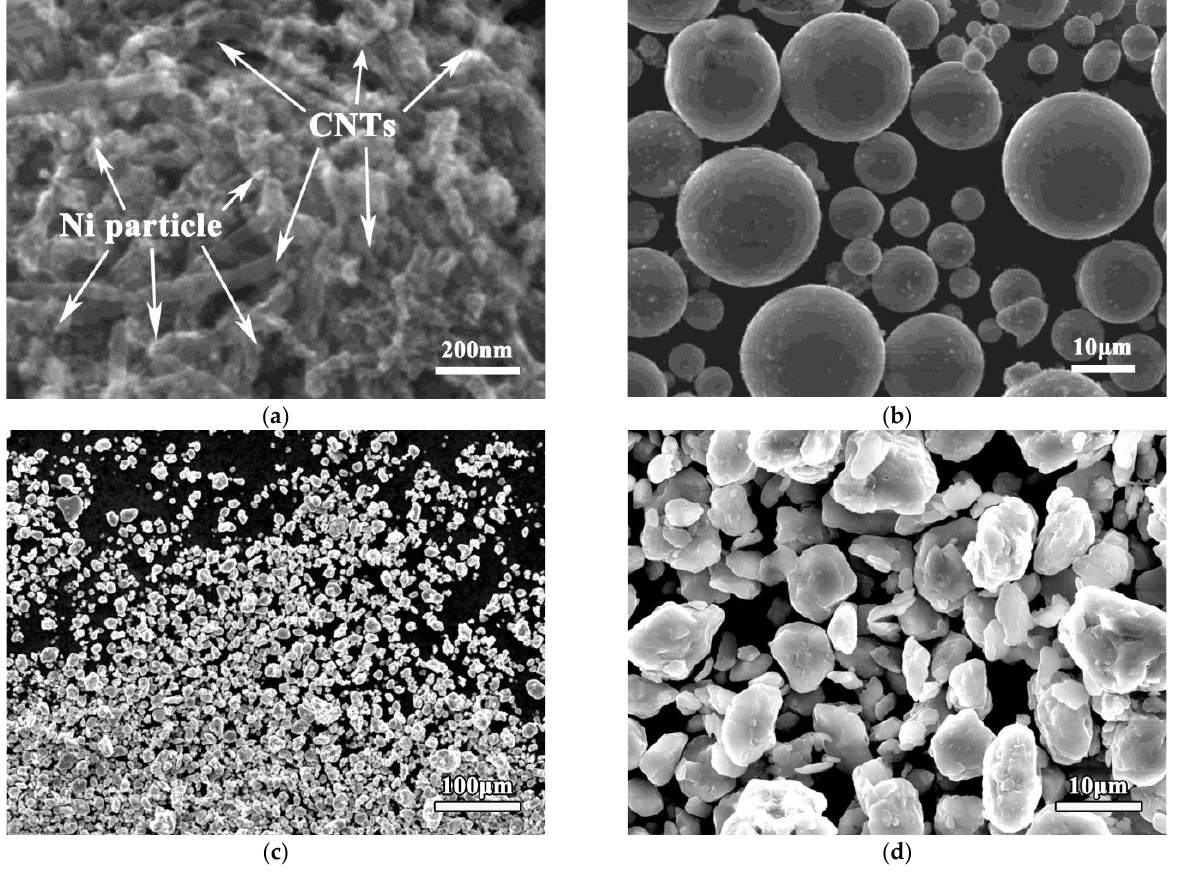
Figure 2. SEM morphology of as-received Ni-coated CNTs ( a ) and as-received ( b ) and ground ( c , d ) pure Mg powders.